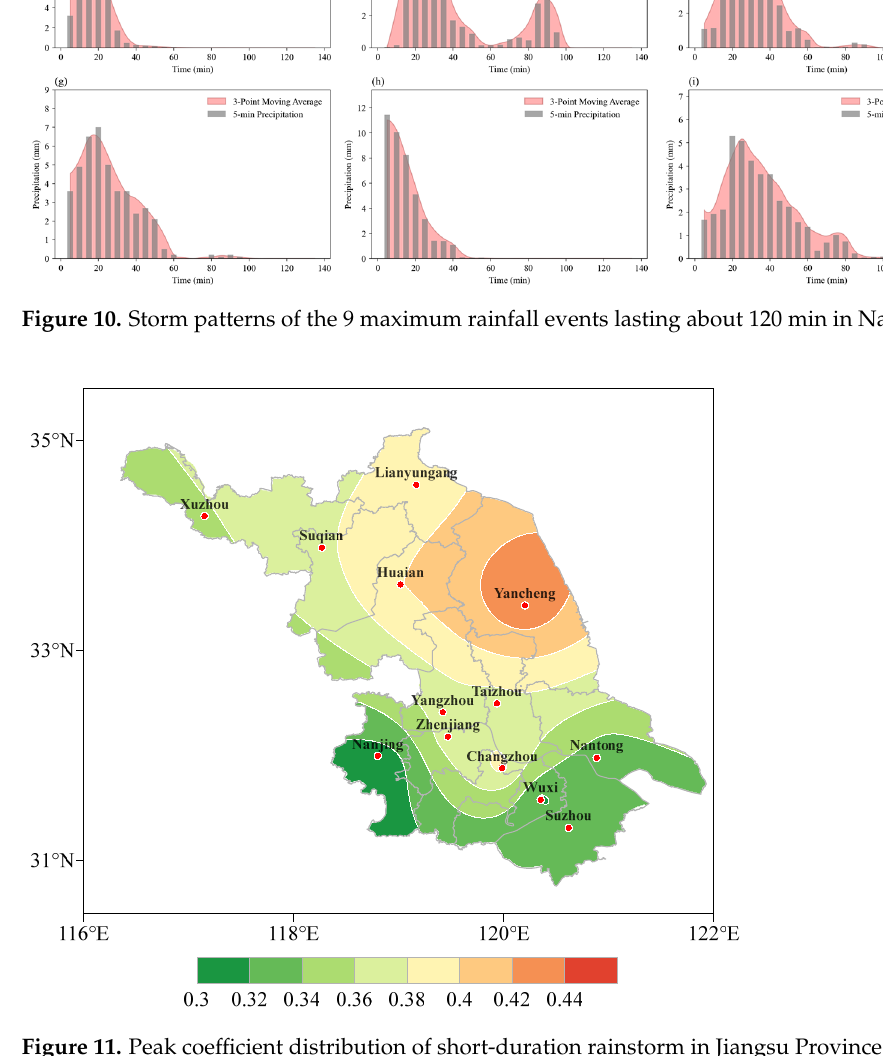
Figure 11. Peak coefficient distribution of short-duration rainstorm in Jiangsu Province.